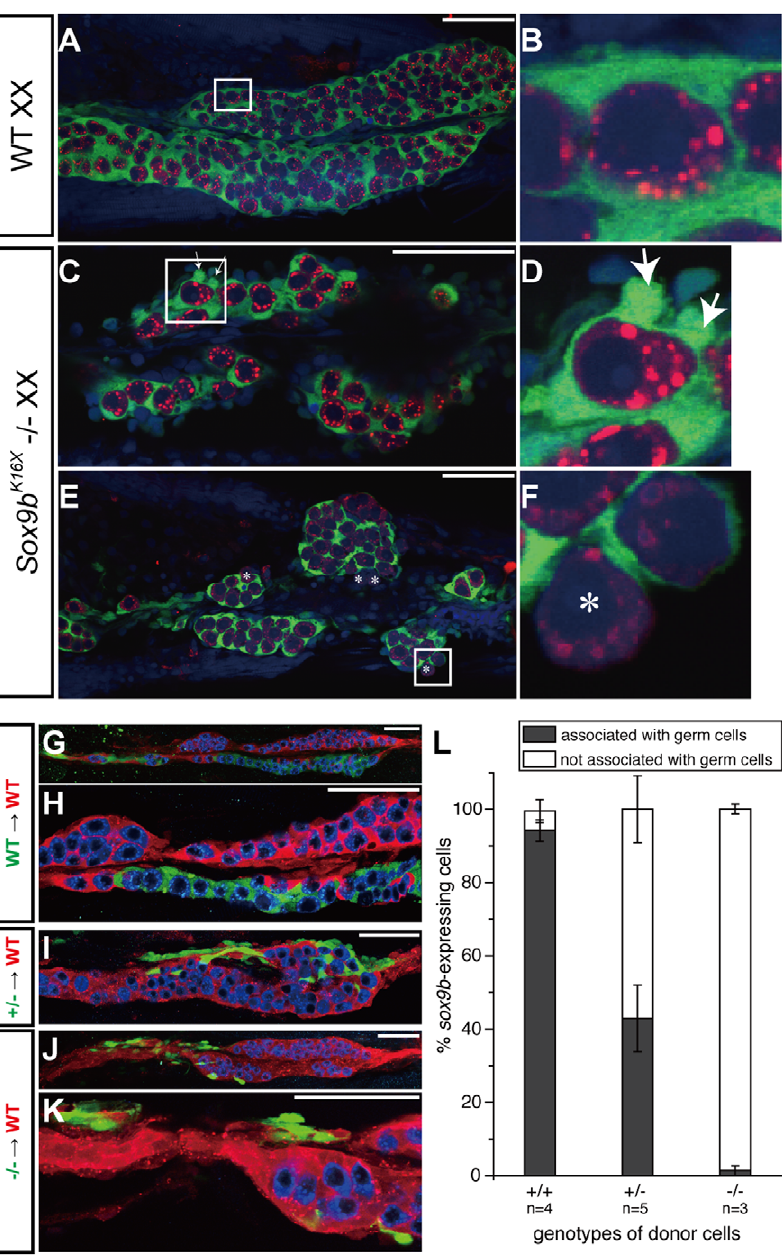
sox9b -DsRed positive cells; blue, germ cells stained with anti-OLVAS. (L) Calculated ratio of donor-derived sox9b -EGFP expressing cells associated with germ cells (black) to those not associated with germ cells (white). Scale bar, 50 m